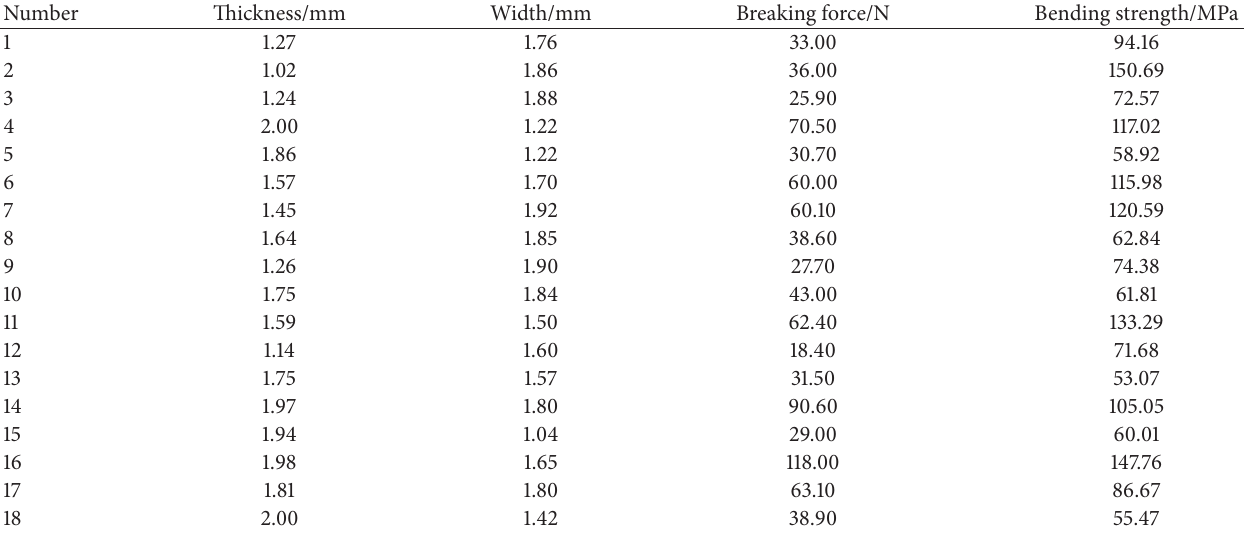
Table 3: Exact dimensions, breaking force, and bending strength of the Er:YAG irradiated specimens (group 2). The mean value of the bending strength is 89.12 MPa with a standard deviation of 36.32